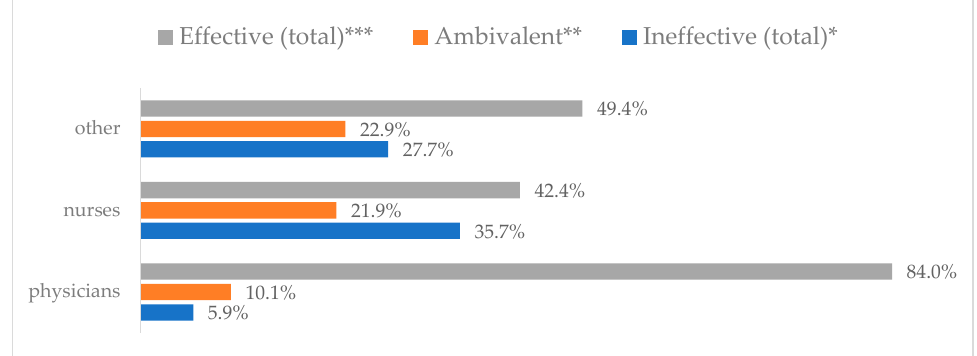
Figure 14. Influenza vaccination to prevent influenza virus infection by profession ( N = 905). *Sum of responses: completely ineffective, ineffective, rather ineffective; **Response: neither ineffective nor effective; ***Sum of responses: rather effective, effective, completely effective.